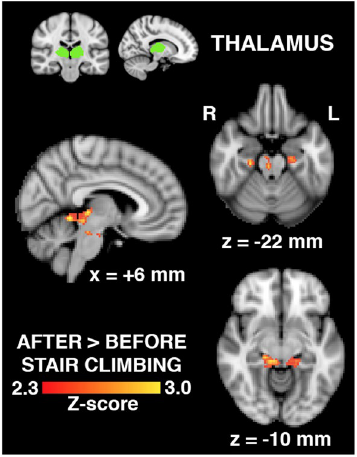
Figure 4. Brain regions (bottom, in red-to-yellow) exhibiting increased connectivity with the thalamus seed region (top, in green) in hip OA patients (n = 30) following physical activity involving the hip, expressed as a statistical Z-score of the difference. Regions include the right brainstem, left and right parahippocampal gyri, and the left and right periaqueductal grey (PAG) (x,z-coordinates of shown brain slices correspond to the MNI brain template).